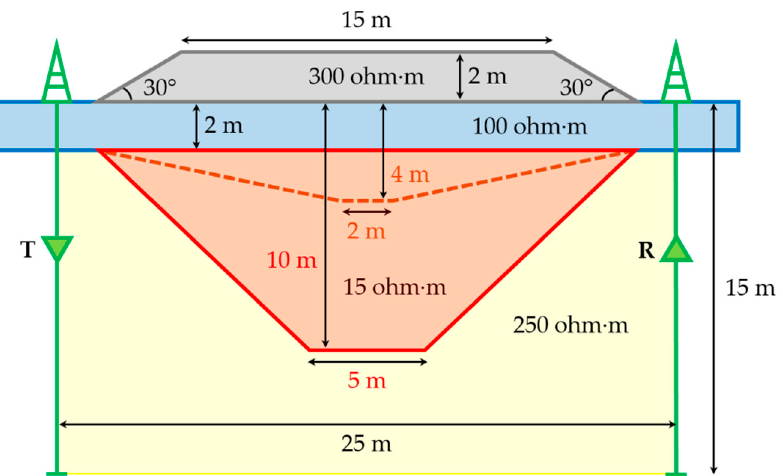
Figure 4. Geoelectric model of a road element with thawed permafrost and the applied geophysical system for cross-well exploration (in section). Gray color: roadbed with embankment, blue: seasonally thawing layer, yellow: permafrost, red: taliks, green: wells with the signal source and receiver. Under the road and seasonally thawing layer, a thaw-affected area (talik) with a trapezoidal cross-section has formed (red). We investigated the cases of two different taliks both having a resistivity of 15 ohm · m: a large one (5 m upper base length, 10 m distance from it to the embankment base) and small (2 m upper base length, 4 m